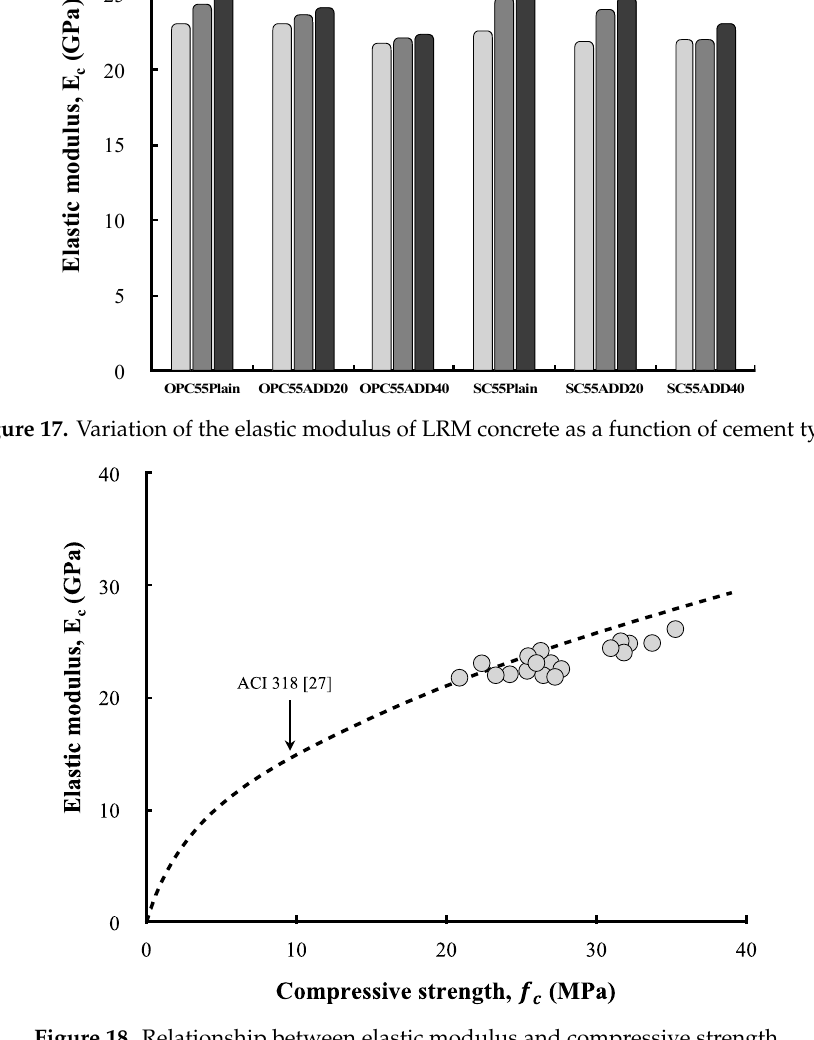
Figure 18. Relationship between elastic modulus and compressive strength.